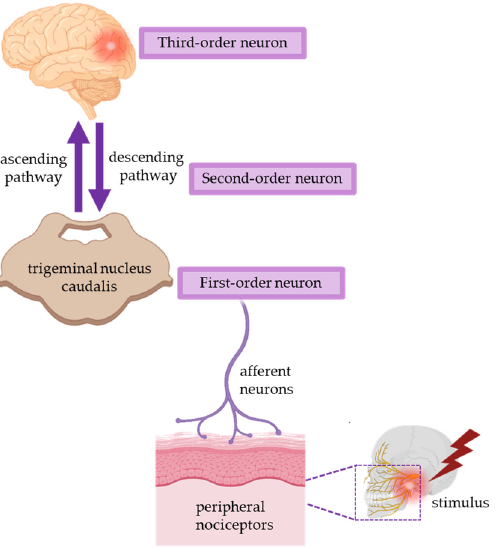
Figure 1. An overview of the physiology of pain in the orofacial region (Adapted from [30] ).